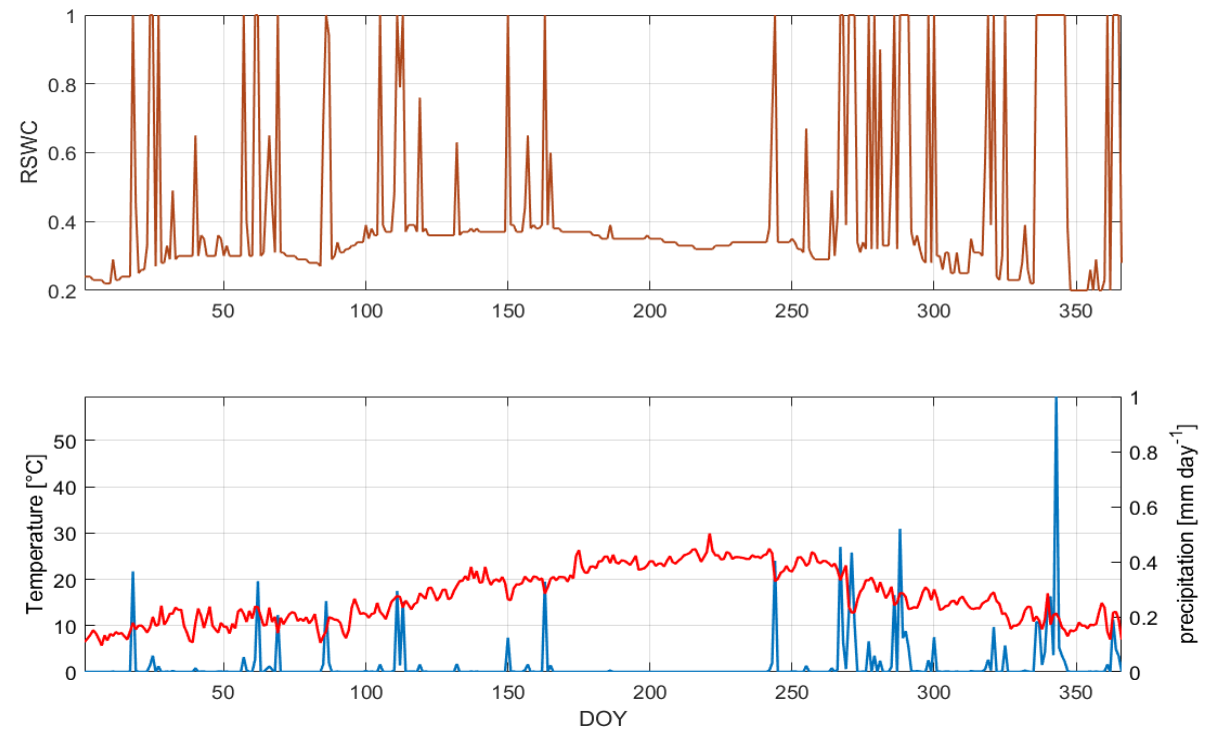
Figure 2. Daily trends of relative soil water content ( RSWC , brown line), temperature (°C, red line), and precipitation (mm, blue line) during 2020. RSWC is a dimensionless value, where this variable assumes a 0 value under the water stress condition ( RSWC = 0) or 1 in absence of the water stress condition ( RSWC = 1).